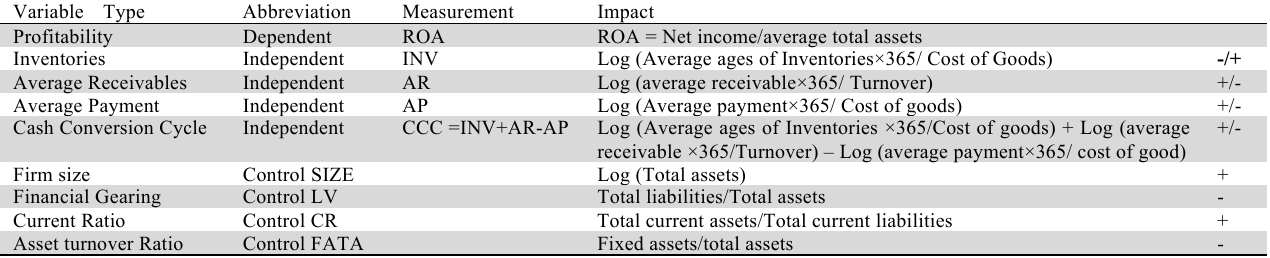
Variable measurement and research